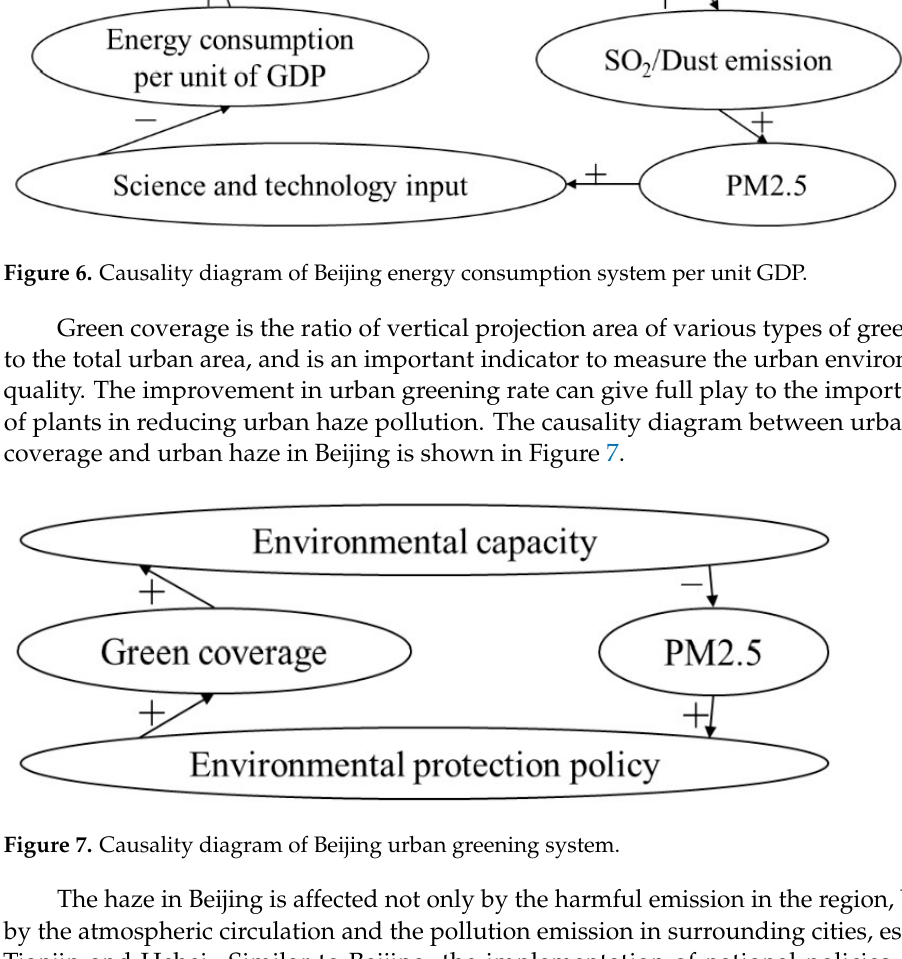
Figure 5. Causality diagram of Beijing coal consumption system.